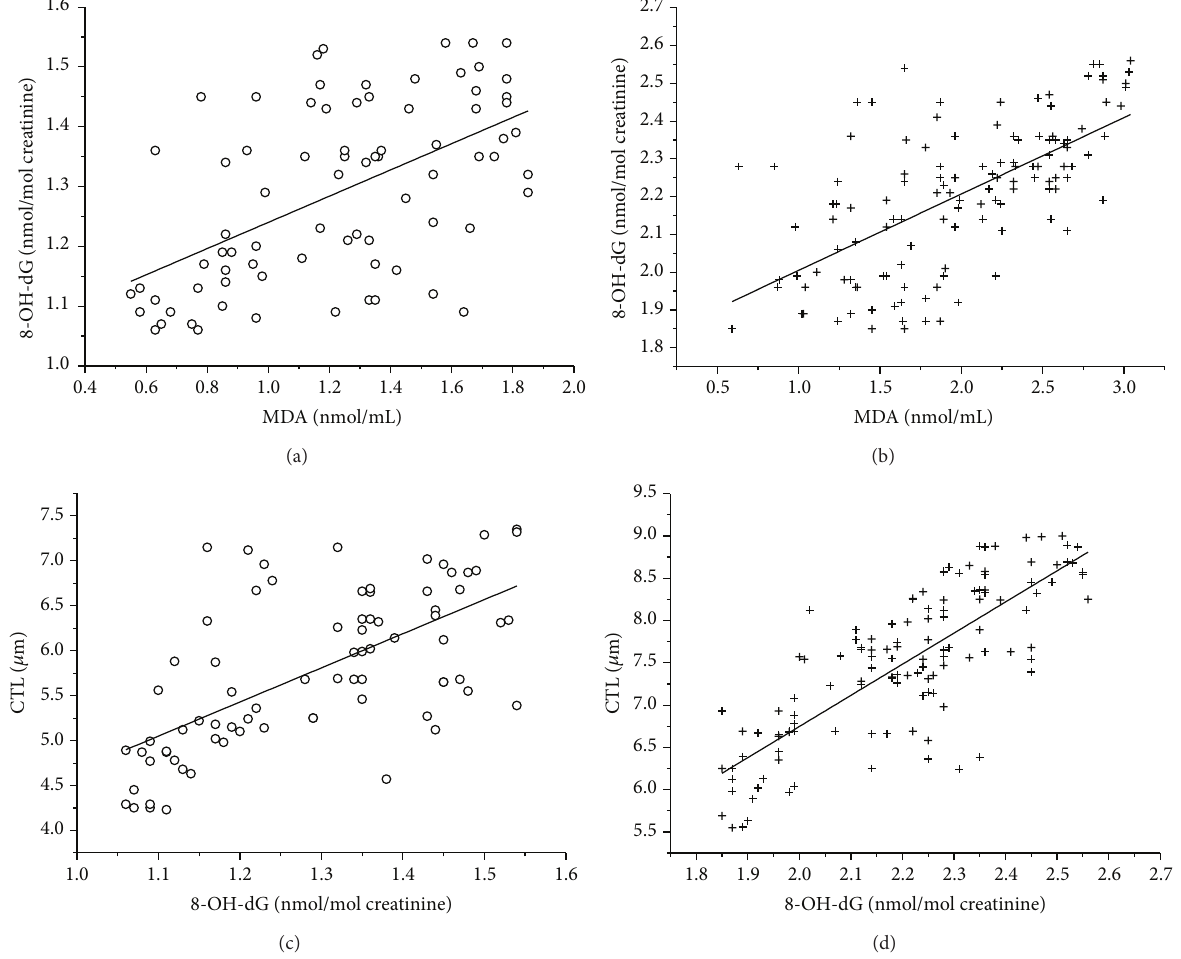
Figure 1: Correlation between MDA level and 8-OH-dG level in lymphocytes of workers in control group ((a), 𝑟 = 0.556 , 𝑃 < 0.001 ) and exposed group ((b), 𝑟 = 0.640 , 𝑃 < 0.001 ), and correlation between 8-OH-dG and CTL level in lymphocytes of workers in control group ((c), 𝑟 = 0.644 , 𝑃 < 0.001 ) and exposed group ((d), 𝑟 = 0.794 , 𝑃 < 0.001